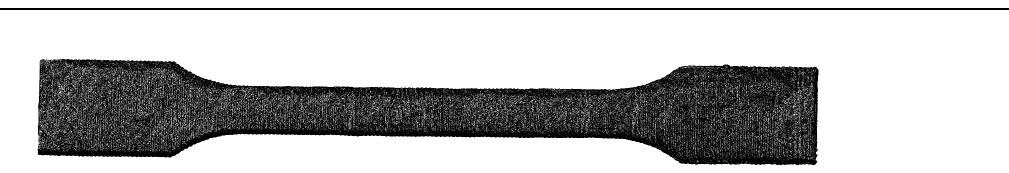
Figure 8. Scanned sample before static tensile test.